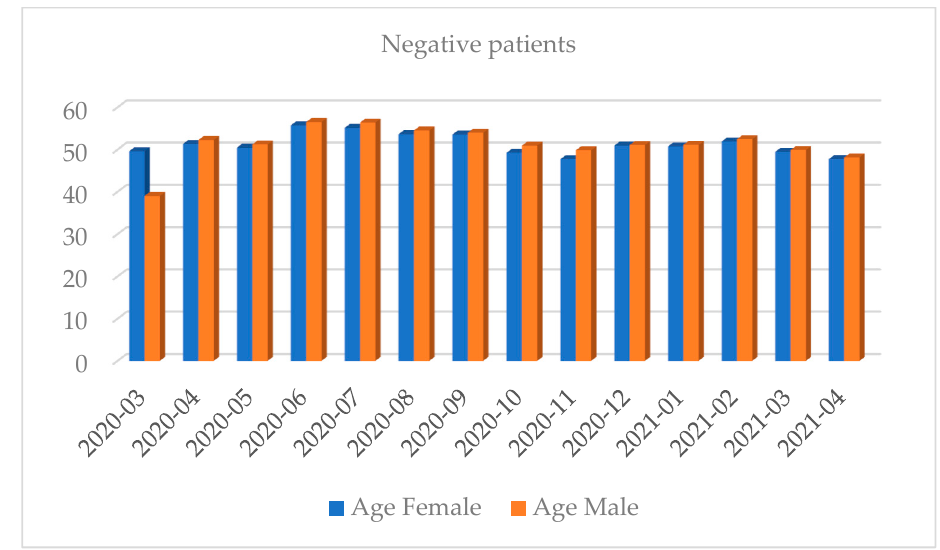
Figure 5. Distribution of negative results by the average age and gender in a given month.